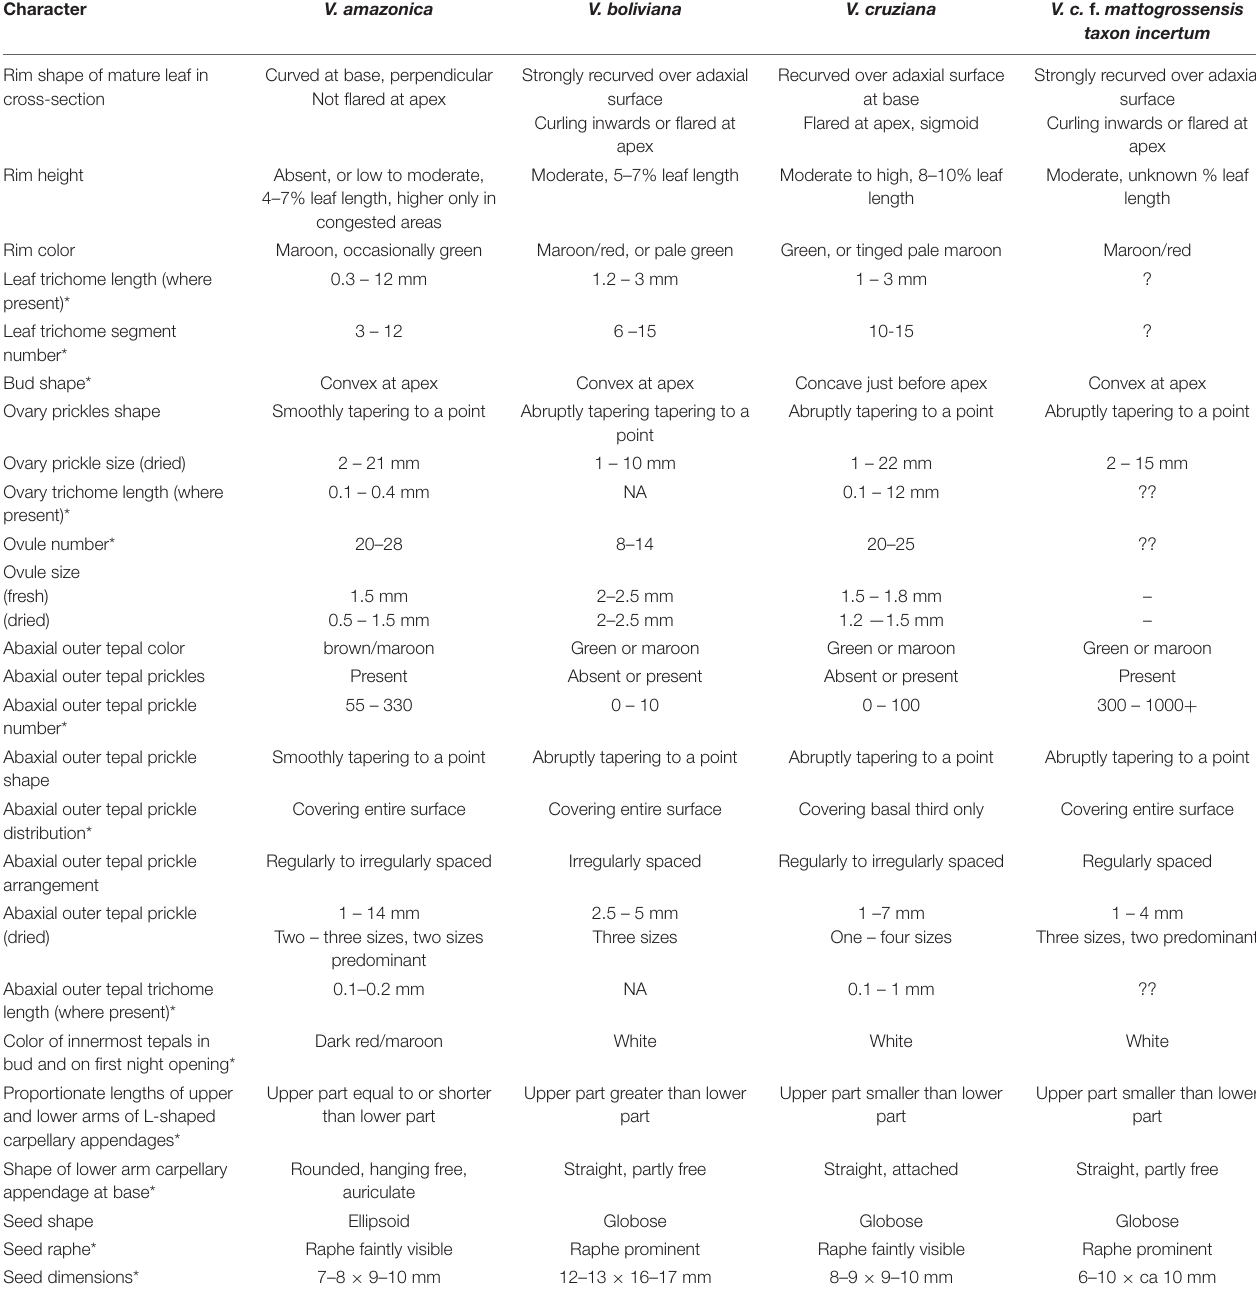
TABLE 2 | Morphological character states used to delimit morphospecies of Victoria